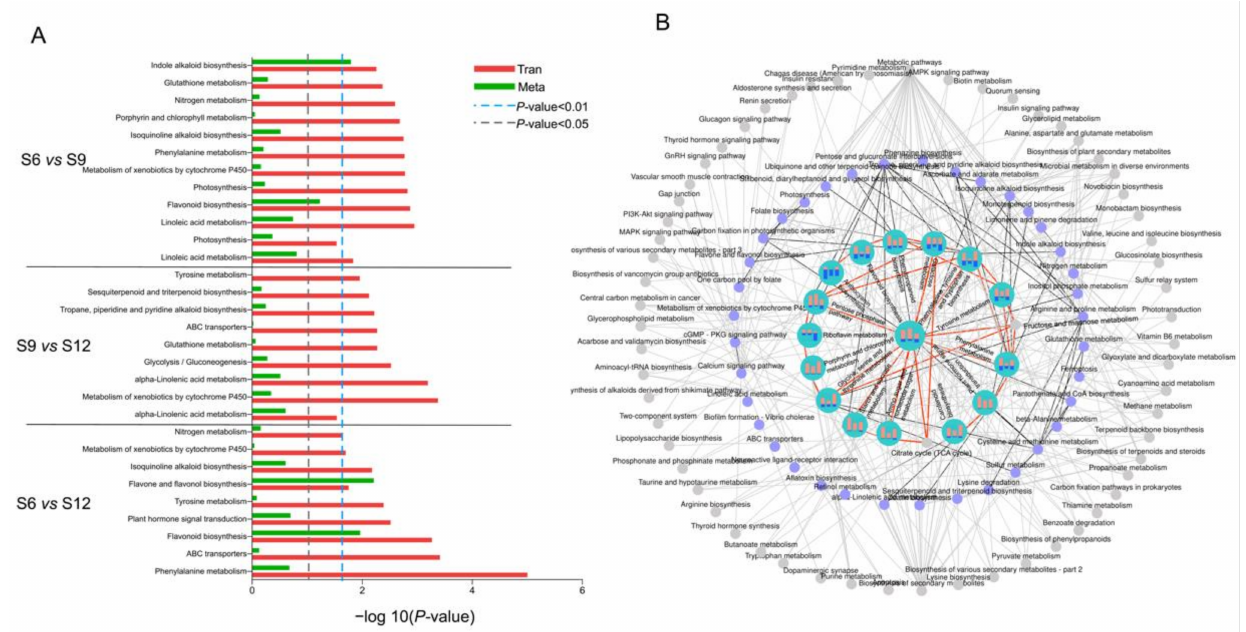
Figure 6. Annotation analysis of KEGG pathway in different developmental stages of sweet cherries. ( A ) KEGG-enriched top 10 pathway analysis of DEGs between each comparison group. Select differential genes with p -values ≤ 0.5 for KEGG enrichment analysis; ( B ) association analysis of each pathway. Different dots indicate different metabolic pathways: gray indicates pathways that were associated with pathways but not enriched in the top 30 or not enriched; purple indicates pathways that were enriched into the top 30 at least in one set of comparison groups; blue circles indicate pathways that were enriched in the top 30 and more closely linked, at least in one comparison group. The bars in the blue circles represent the number of DEMs and DEGs in three different developmental stages, respectively, red represents the number of DEGs contained in the pathway, and blue represents the number of DEMs in the